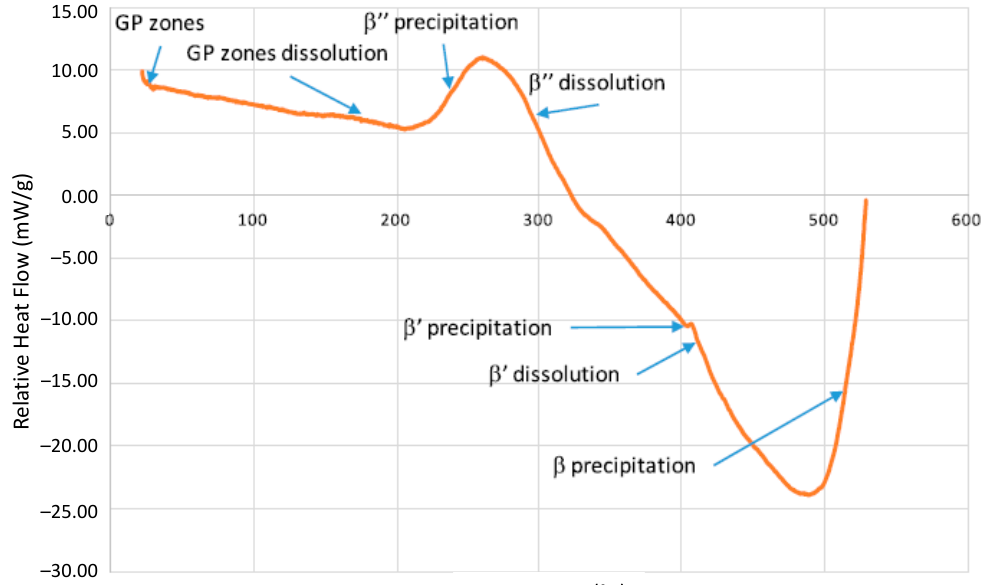
Figure 9. Image analysis was performed on the EDS mapping areas taken at several locations in the TEM sample. A histogram of the size results of the Mg-Si and Fe particles is shown herein. Accordingly, the precipitate radius size distribution of Mg, Si, and Fe intermetallic phases within an as-atomized Al 6061 powder particle is presented. The solutionized sample was scanned in the DSC, described in the Methods and Ma- terials section previously documented, and held at 540 °C for 1 h. The DSC curve is plotted